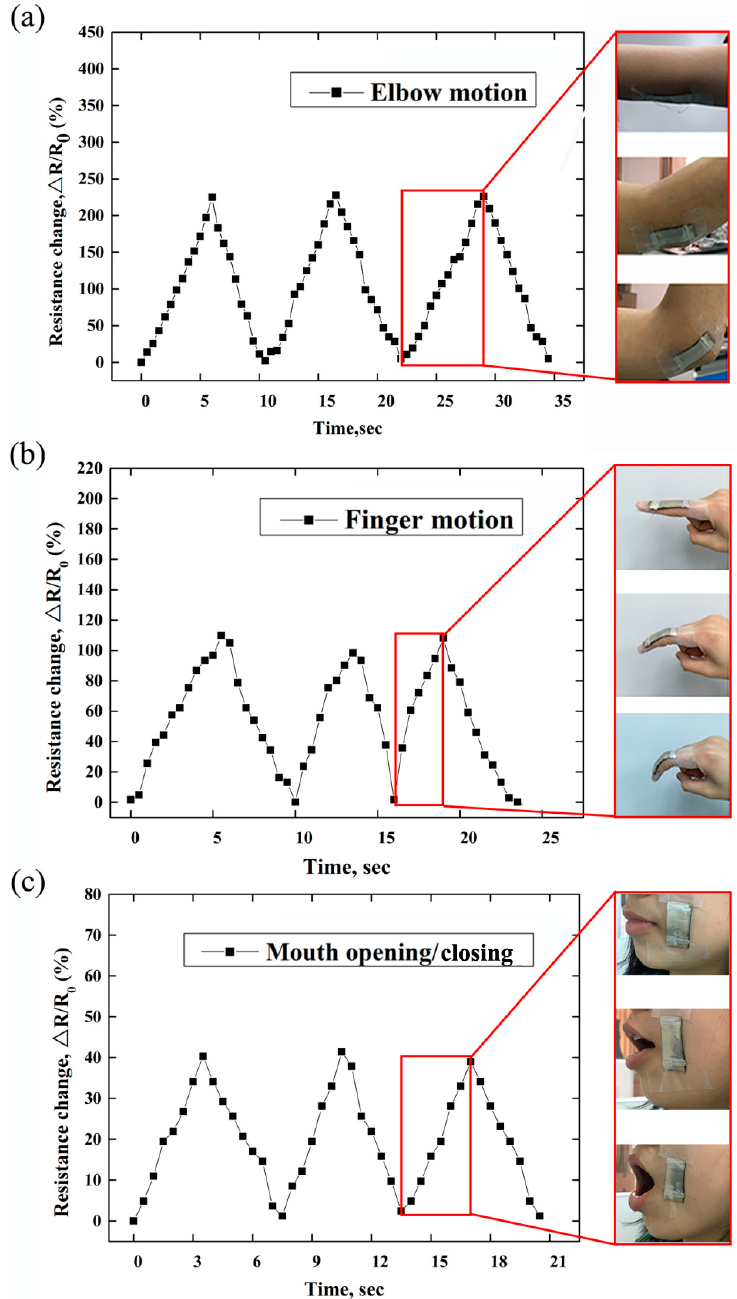
Figure 5. Δ R / R 0 profiles of the stain sensor under motions of the ( a ) elbow, ( b ) finger and ( c ) mouth.